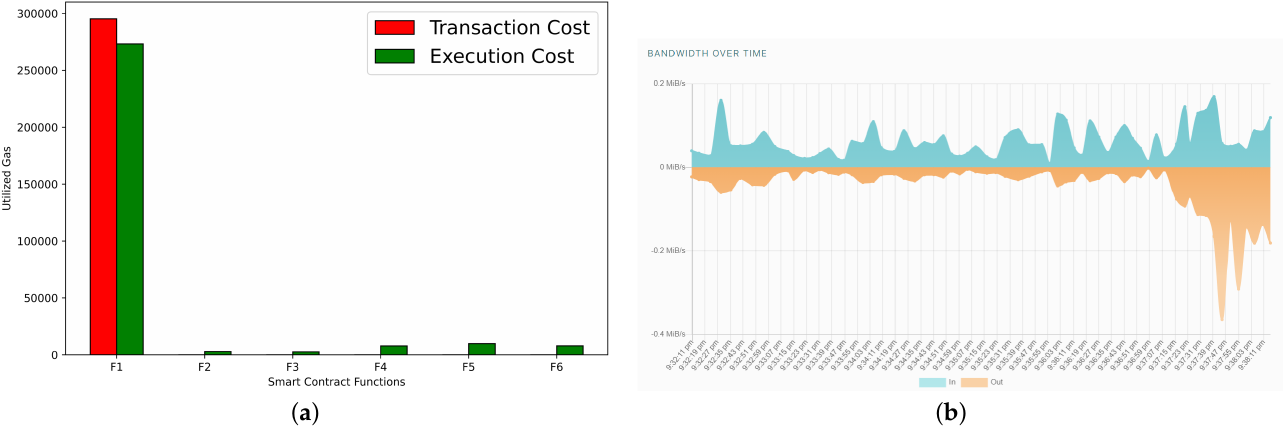
Figure 11. ( a ) Gas cost consumption. ( b ) IPFS bandwidth